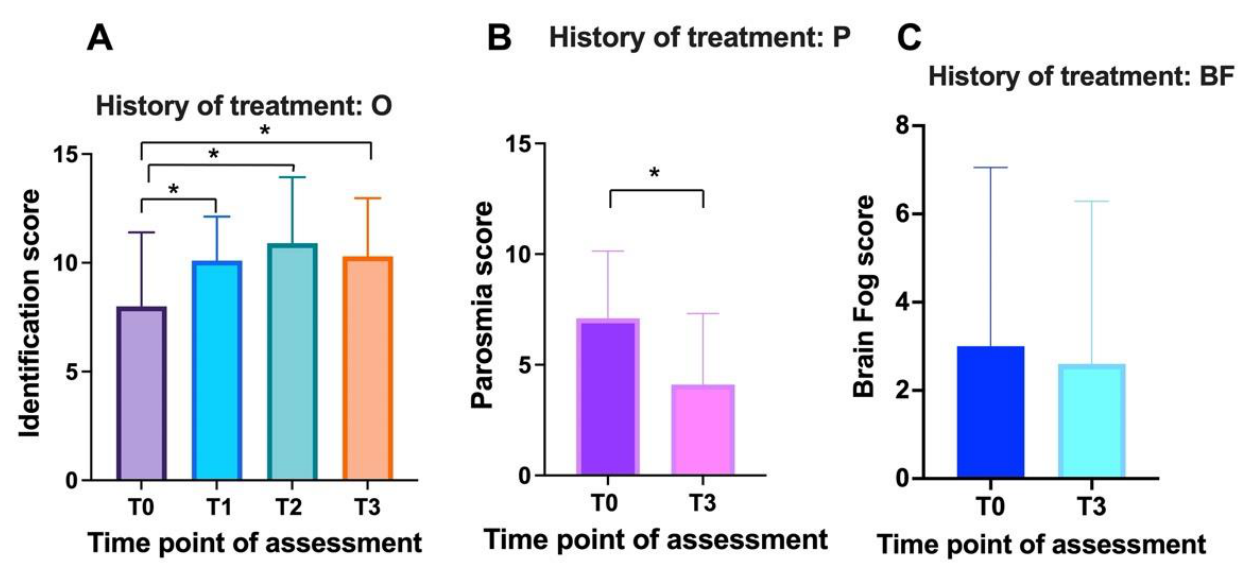
Figure 6. Effect of PEA-LUT treatment plus olfactory training on olfaction, parosmia, and mental clouding in patients with prior olfactory training (previously treated group): ( A ) O (olfaction) results of identification test at T0 (baseline), T1 (1 month), T2 (2 months), and T3 (3 months); ( B ) P (parosmia) before (T0) and after three months (T3) of treatment; ( C ) BF (brain fog/mental clouding) before (T0) and after three months (T3) of treatment. *: p <